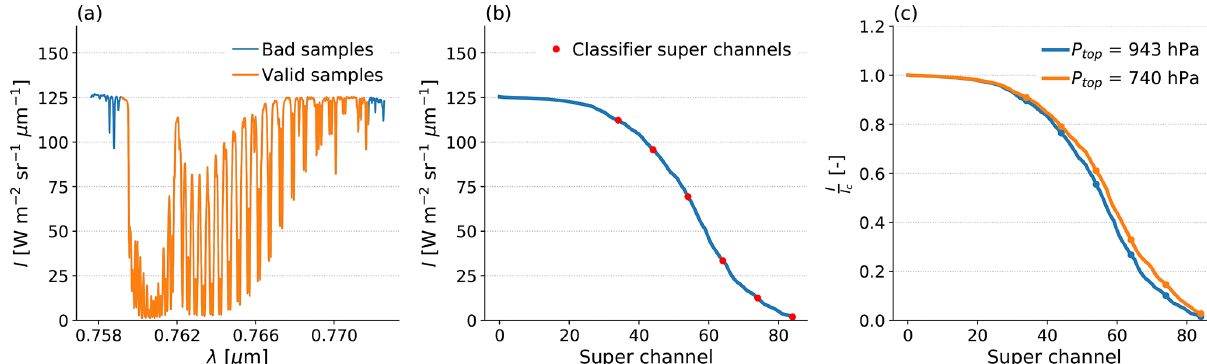
Figure 1. (a) OCO-2 A-band spectrum for a cloud with CALIPSO P top = 943hPa, with the used channels in orange and non-used (e.g. due to FPA pixel damage) in blue. (b) The smoothed super-channel spectrum, where the channels are ranked in brightness and then non-overlapping 10-channel means are taken. The super channels used in the classifier are shown in red. (c) Comparison of the ranked ratio I/I c between this cloud, and one at a higher altitude ( P top = 740hPa). The SZA is within 0.01 ◦ , and the continuum radiance is within 1% between each spectrum; the differences are largely due to the shorter path length resulting in less absorption for the higher-altitude